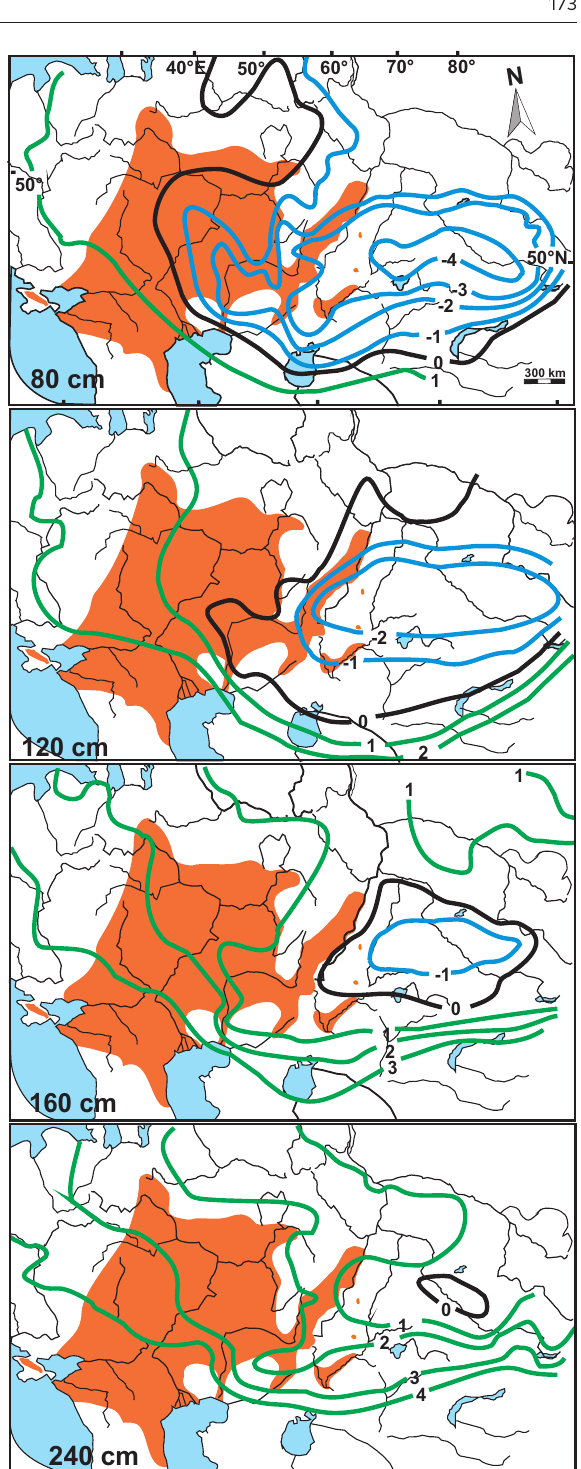
Figure 2. Soil isotherms (°C) in the coldest months and range of the Pallas’ spadefoot (shaded). Soil isotherms (°C) at differ - ent depths in the coldest months: European Russia, southern West Siberia and west Kazakhstan. Geographic range of the Pallas’ spadefoot (shaded), numbers in the left lower corners represent depth of the measurement made by weather